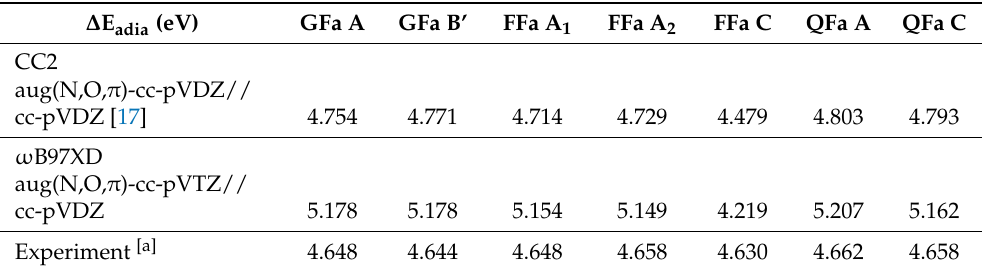
Table 5. Adiabatic ZPVE-corrected excitation energies of the lowest ππ * excited state (S 1 ) of the GFa A and B’, FFa A 1 , A 2 and C and QFa A and C conformers obtained at the CC2/aug-(N,O, π )-cc- pVDZ//CC2/cc-pVDZ and ω B97X-D/aug-(N,O, π )-cc-pVDZ// ω B97X-D/cc-pVDZ levels, together with the experimental 0–0 transition